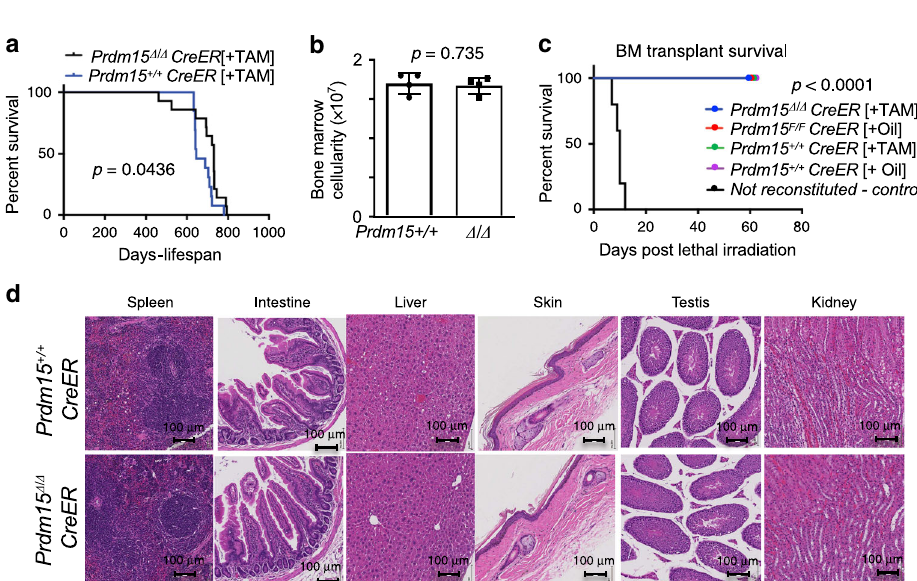
Fig. 2 PRDM15 is largely dispensable for normal adult murine homeostasis. a Survival curve of PRDM15 + / + Rosa26;CreER ( n = 13) or PRDM15 F/F ;Rosa26; CreER ( n = 14) mice that were injected with Tamoxifen (TAM) at 8 weeks of age ( Prdm15 Δ / Δ ) . b Bone marrow cellularity and white blood (WBC) cell counts of PRDM15 + / + and PRDM15 Δ / Δ mice 2 months after tamoxifen injection ( n = 4). Center values, mean; error bars, s.d. Student ’ s t test (two- sided) was used for statistical analysis. c Survival rate of mice that were lethally irradiated and then reconstituted with cells derived from mice with the indicated genotypes ( n = 5 for each group). In black, the non-reconstituted control. d Representative histology images showing H&E staining of various organs from PRDM15 + / + and PRDM15 Δ / Δ mice 2 months after tamoxifen injection (scale is 100 μ m). In panels a and d , log-rank test was used to determine statistical signi fi